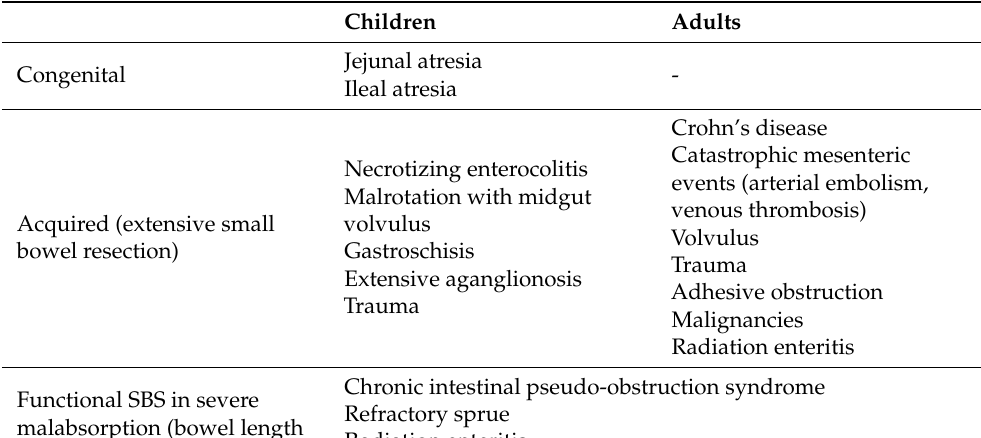
Table 1. Overview of causes of small bowel syndrome in children and adults. Adapted from Buchman and DiBaise et al.